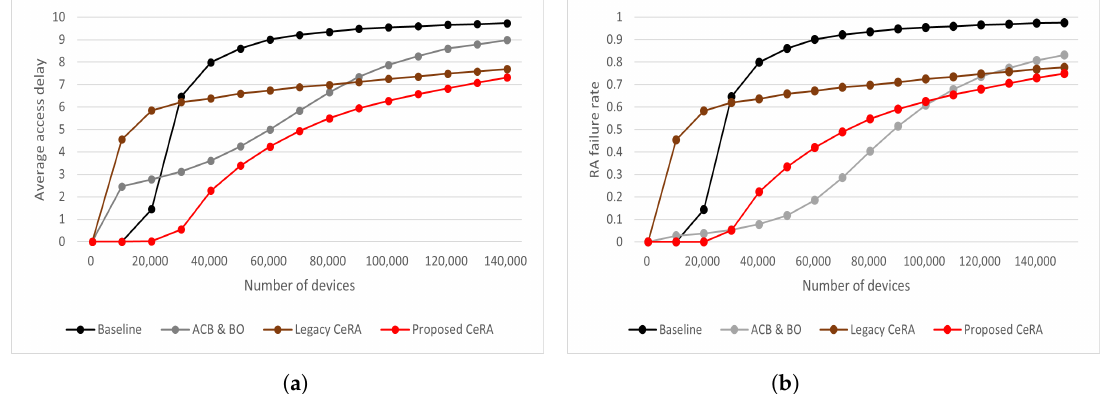
Figure 7. ( a ) Average delay for different consistency. numbers of devices and ( b ) RA failure rate for different numbers of